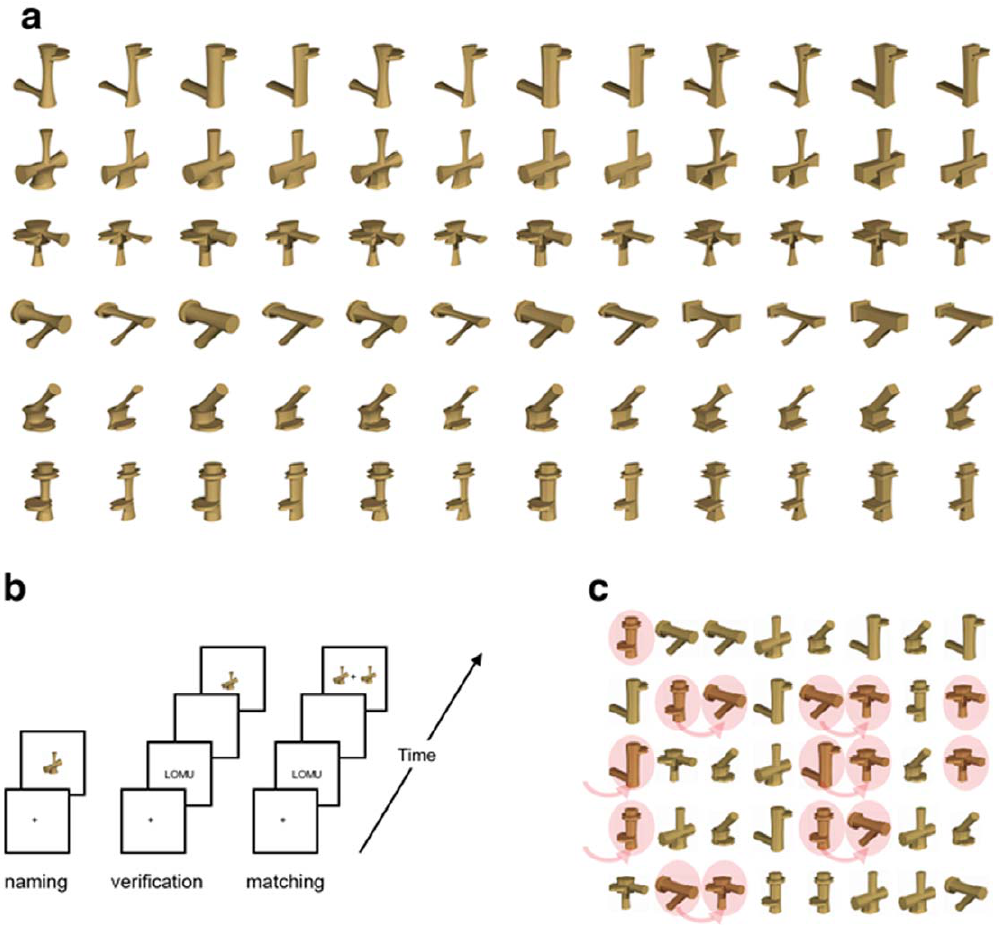
Figure 1. The artificial objects (Ziggerins) and training tasks. (a). The entire Ziggerin set of seventy-two novel objects. The six classes were shown in separate rows. (b). Individuation training consisted of three tasks: naming, verification, and matching. (c). Categorization training consisted of the naming and verification tasks, as well as a matrix scanning task with an example trial shown. doi:10.1371/journal.pone.0008405.g001 tended to have larger configural effects and larger training effects categorization-training [within: r = .82, P =.006; between: r =.49, P = .185] and individuation-training groups [within: r =.50, than participants in the categorization-training group. The P = .167; between: r = .60, P = .084]. There were no significant correlations remained high with separate analyses for the